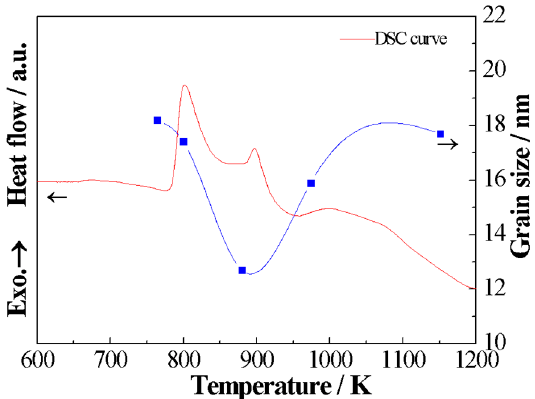
Figure 4. Variation of crystallinity as a function of annealing temperature for the (Fe 0.4 Co 0.6 ) 79 Nb 3 B 18 alloys.